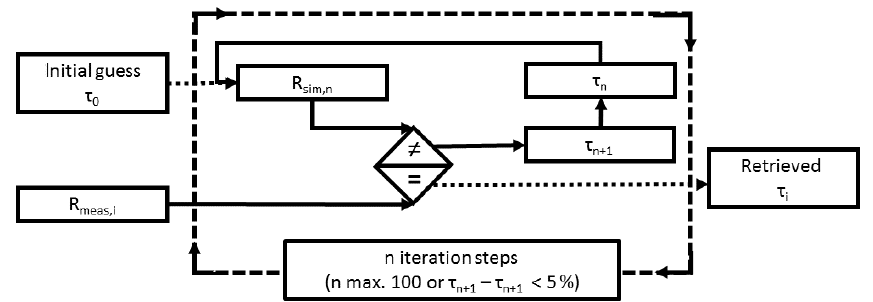
Figure 11. Scheme of the iterative algorithm. For every single measurement i an iteration loop is started with an initial guess τ 0 until measured R meas and simulated R sim reflectivity converge within 5% difference or a maximum of 100 iteration steps is reached. At the end of the process the result is saved.